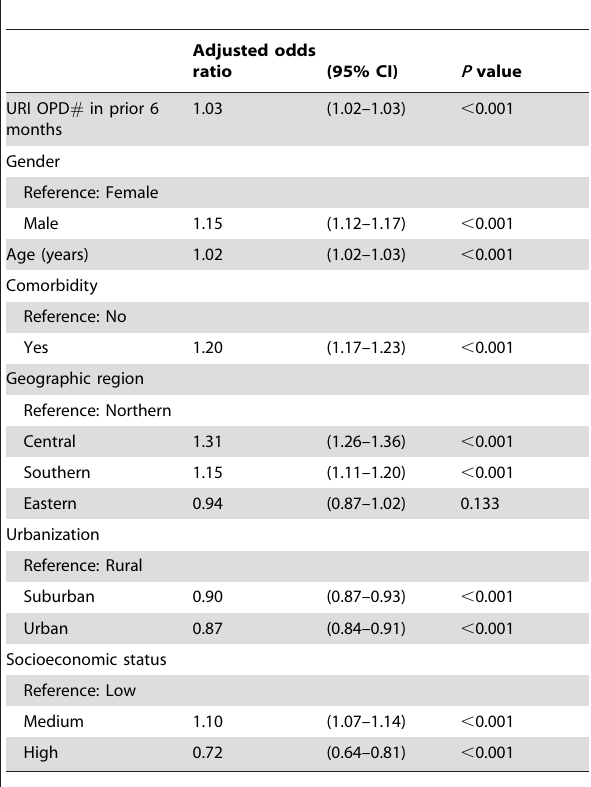
Table 2. Predictors for influenza vaccination in the elderly